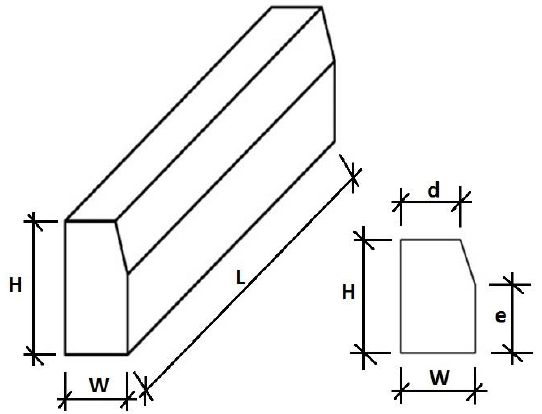
Figure 15. Description of the curbs’ geometry according to EN 1340:2004 [16].